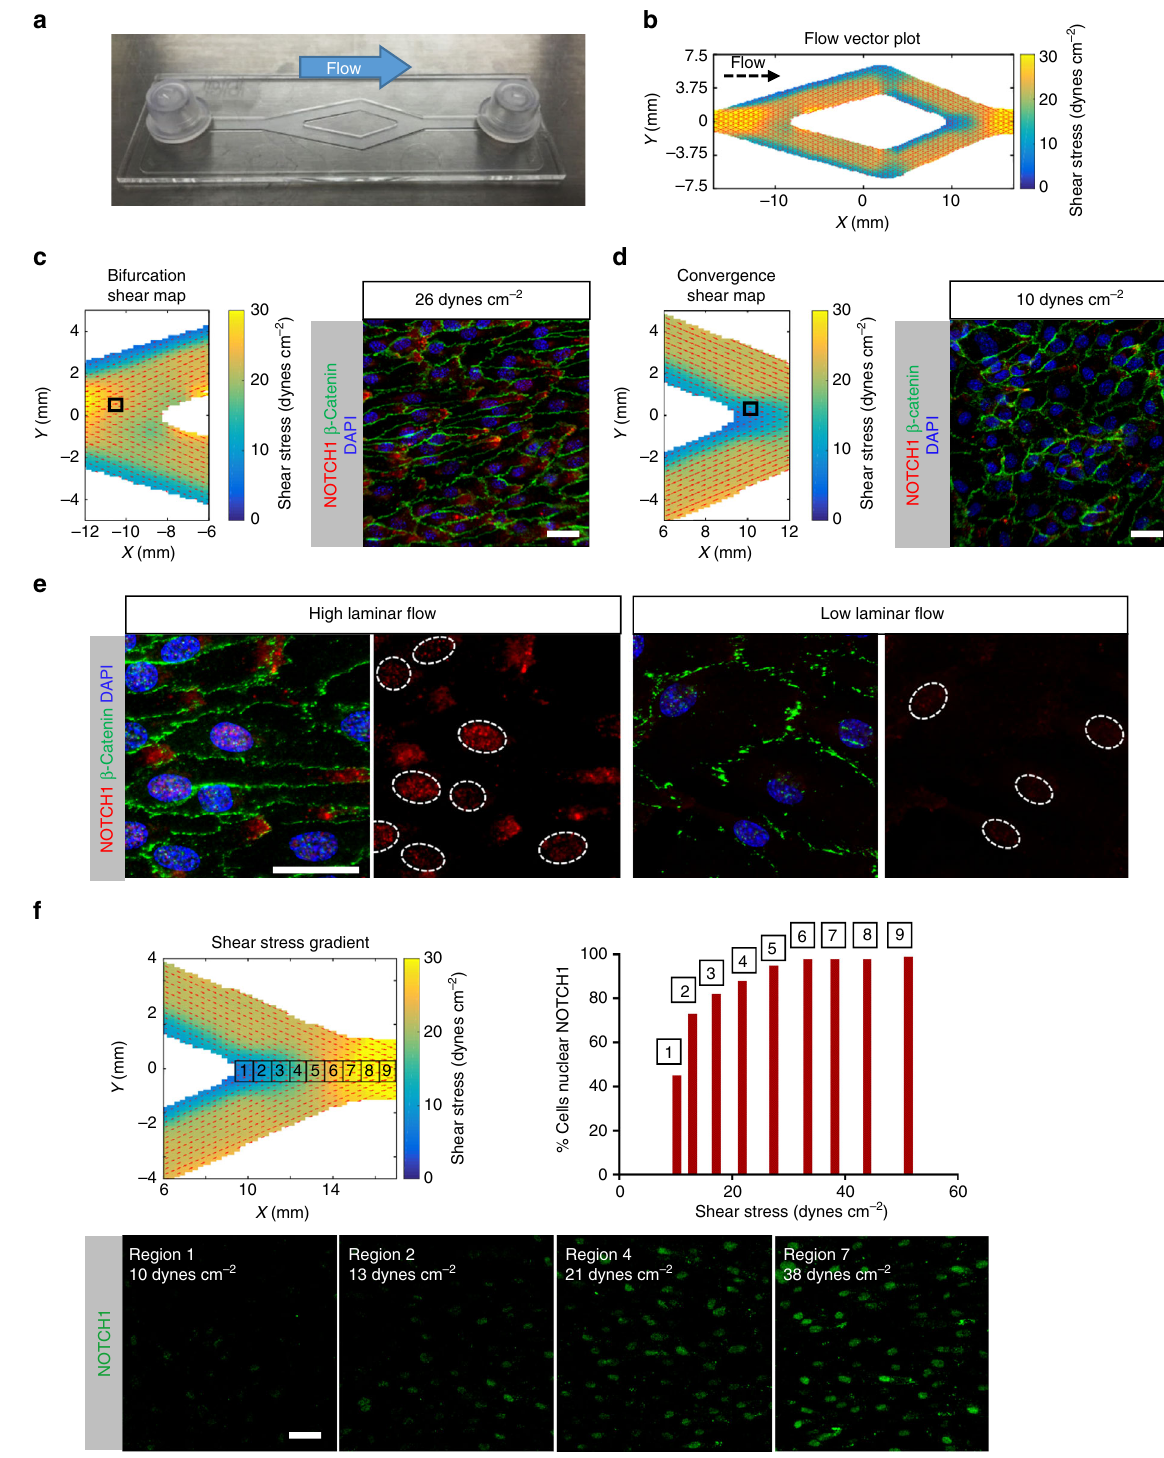
Fig. 2 Shear stress potentiates activation and consequent nuclear translocation of NOTCH1 protein. a Endothelial cells (HAECs) were plated to con fl uency on a y-slide (ibidi) and subjected to laminar fl ow (9 mL min − 1 applied). b MRI fl ow mapping of y-slide in the presence of fl ow-conditioned HAECs (48 h) generated fl ow vector plots across all regions of the y-slide ( n = 5). c Flow vector plot of high fl ow speed (26 dynes cm − 2 ) region and corresponding HAEC morphology. Notice cell shape de fi ned by β -catenin expression at cell – cell borders (green) and polarized NOTCH1 (red) protein. Scale bar = 20 µ m. d Flow vector plot of low shear stress (10 dynes cm − 2 ) region and corresponding HAEC morphology with β -catenin (green) and NOTCH1 (red). Scale bar = 20 µ m. e Staining for NOTCH1 (red) in high- fl ow region compared to low- fl ow region. Dashed white ovals reveal increase of nuclear NOTCH1 protein under high fl ow compared to low fl ow. Scale bar = 20 µ m. f Flow vector plot of the back end of the y-slide for nine regions of interest. NOTCH1 (green) nuclear staining was quanti fi ed for each of the nine regions and plotted as a function of the measured wall shear stress. For each measurement, ~100 cells were evaluated using n = 5 biological replicates, scale bar = 20 µ